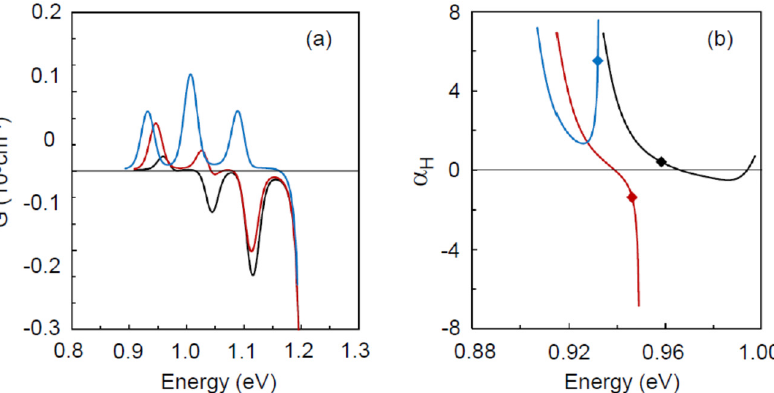
Figure 4(b), the photon energy covers only the GS transition, with the dots indicating gain peak